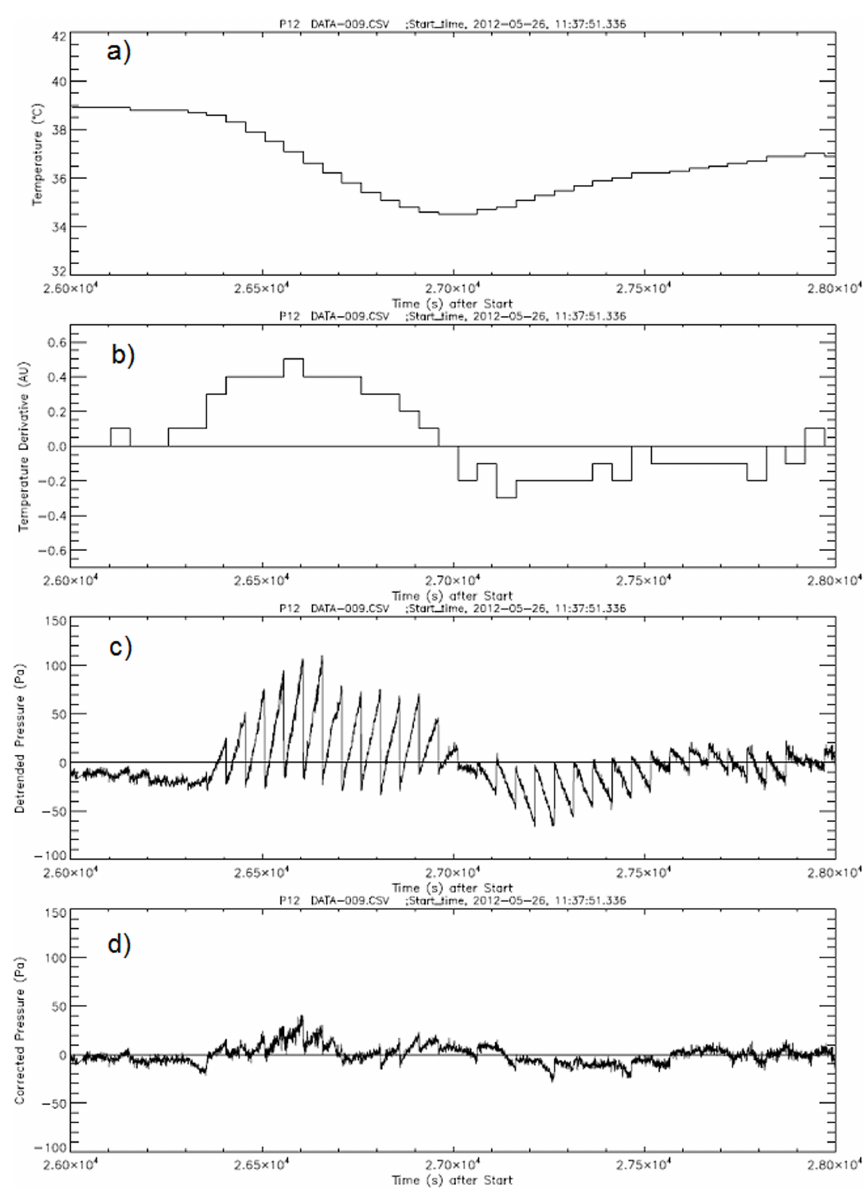
Fig. 8. The 2000s of data from Fig. 6 showing (a) the temperature evolution (note 0.1 ◦ C quantization) and (b) the temperature increment between successive samples (acquired at 100 pressure-sample intervals, or 50s). The pressure readings (c) show a ∼ 100Pa sawtooth noise due to improper temperature correction – it is seen that the sawtooth amplitude and sign correlates rather well with the temperature derivative rate. (d) A post-processing correction algorithm subtracts a sawtooth correction (i.e., a cyclic ramp with a period of 50s, synchronized to the temperature reading) with an amplitude proportional to the temperature derivative in (c) : it is seen that the noise is reduced by a significant factor ( ∼ 3–4) to ∼